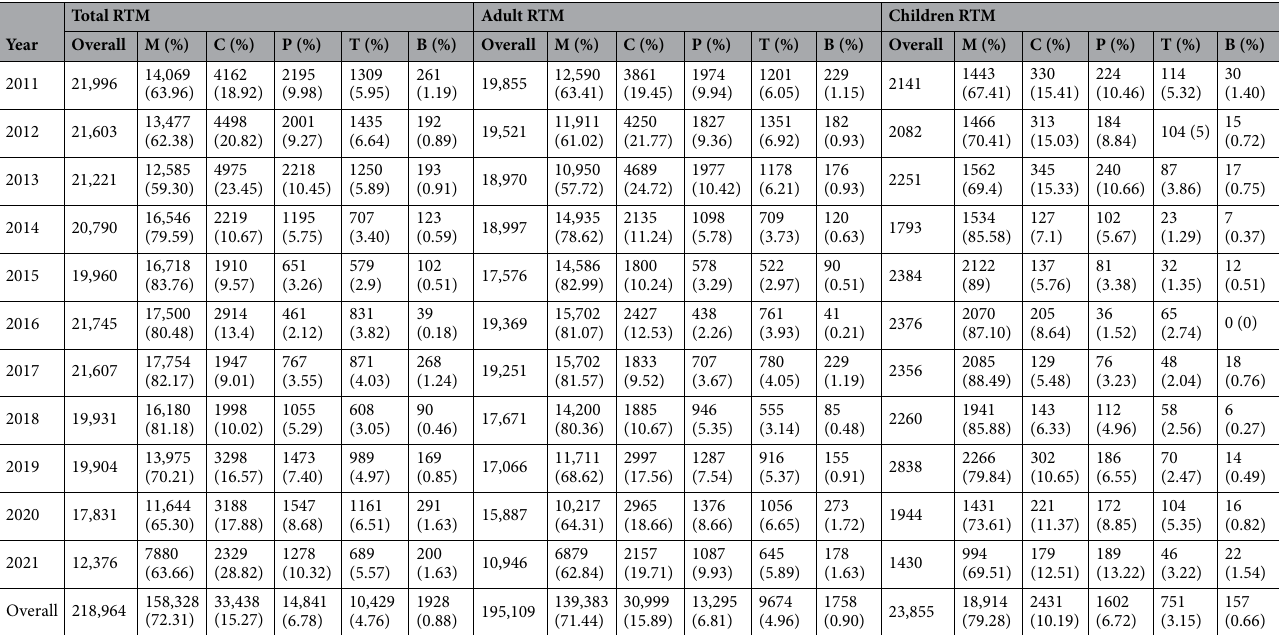
Table 2. The number and percentages of road traffic mortalities (RTM) per year according to type of accident (M; motorcycles, C; cars, P; pedestrians, T;trucks including ten wheelers and agriculture vehicles, and B; bicycles) during 2011–2021.